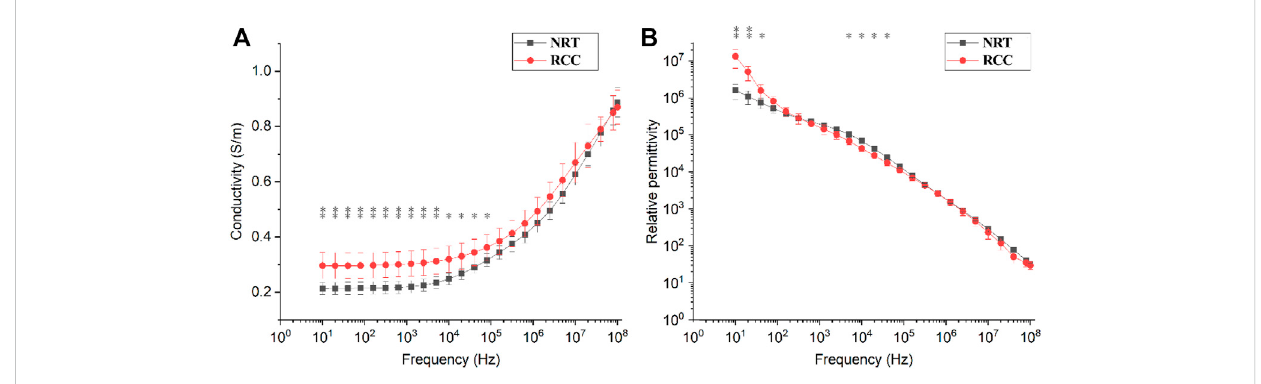
FIGURE 2 Changes in (A) conductivity and (B) relative permittivity of normal renal tissue (NRT) and renal cell carcinoma (RCC) with frequency. * p < 0.05, ** p <